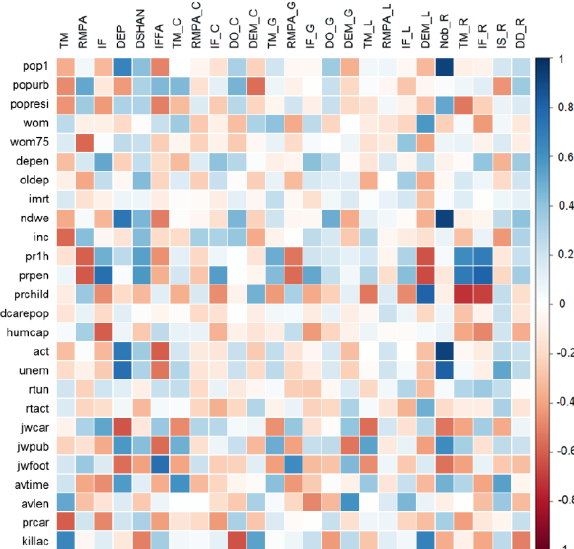
Figure 6. Correlation coefficients between the fragmentation metrics and the socio-economic variables from 2006. The sub- index refers to each land use: commercial (C), green areas (G), leisure (L), residential (R), and its absence means FUA level. Label names are as in Table 1 and Table 2.